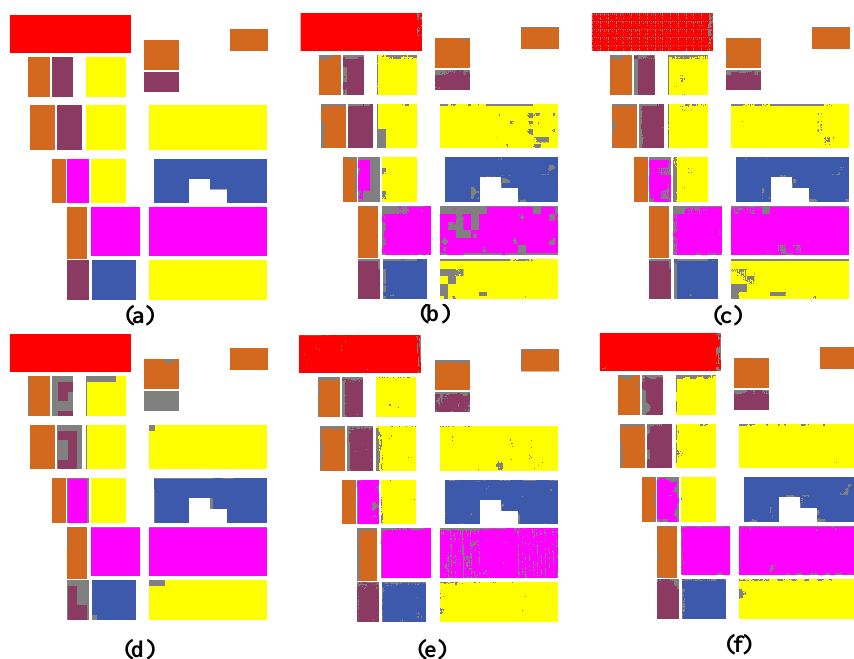
Figure 12. Visual display of classification on Flevoland. ( a ) GT. ( b ) RV-CNN. ( c ) CV-CNN. ( d ) LS-QCNN. ( e ) STS. ( f ) FS-SCNN.